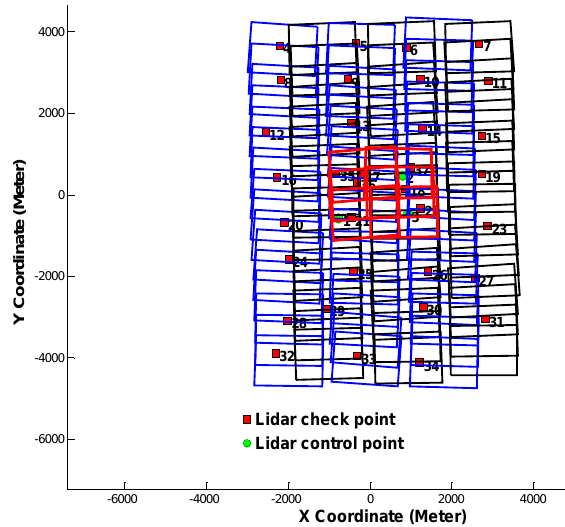
Figure 1. Layouts of the entire images block and the sub-block (red lines) and spatial distribution of the 37 LCPs.